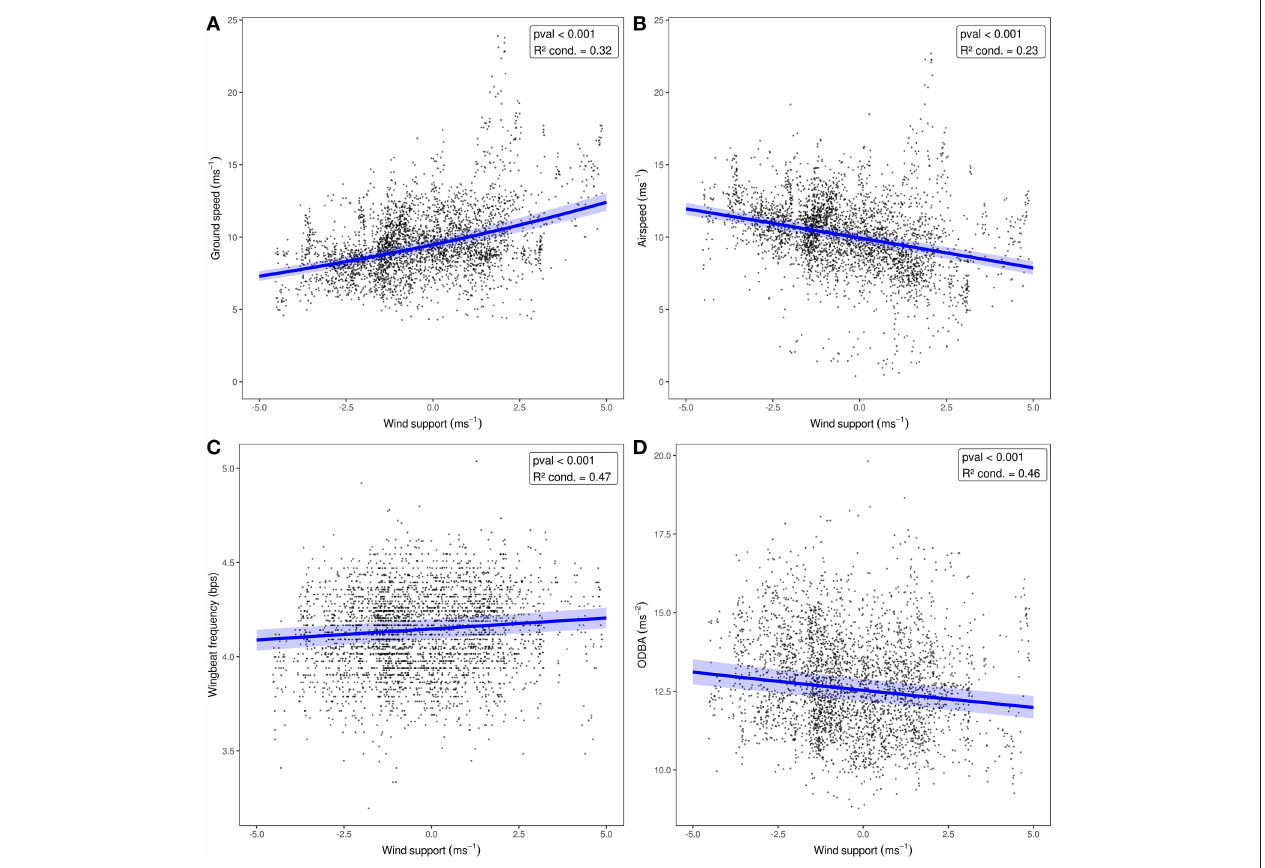
FIGURE 2 | The effect of wind support (headwind to tailwind) on E. helvum flight behavior when crosswinds are held at zero. GLMM results are shown in blue for (A) ground speed, (B) airspeed, (C) wingbeat frequency, and (D) ODBA. The 95% confidence interval for each model, including random effects, is shown as the shaded area around the